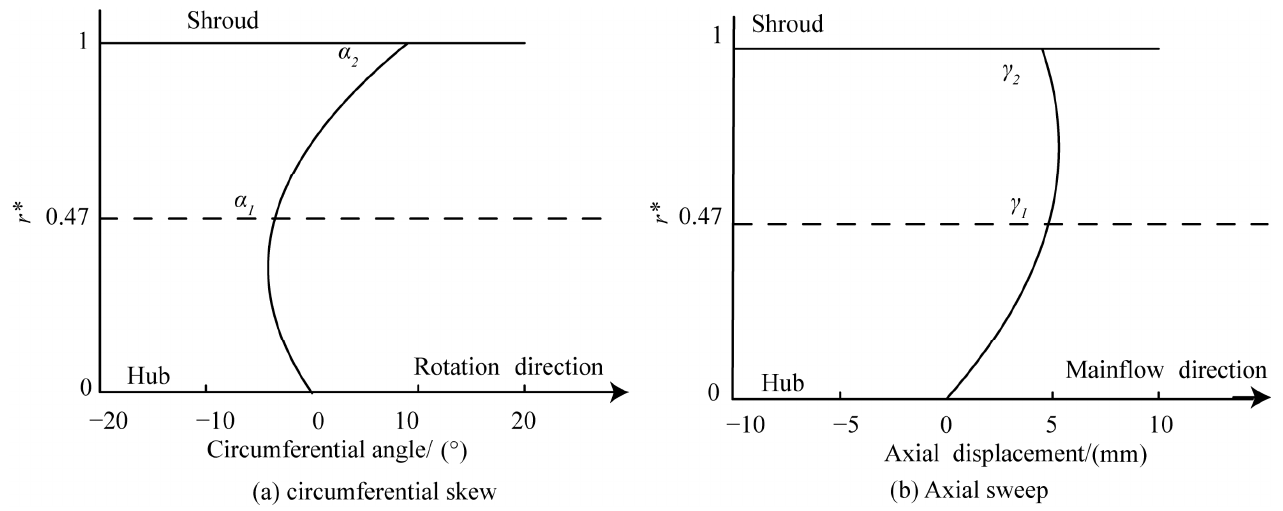
Figure 6. Schematic diagram of the blade stacking modes. Based on the above analysis, the impeller has a total of 12 design parameters, and the value range of each parameter is shown in Table 2. Among them, the variation range of the solidity, hydrofoil stagger angle, and hydrofoil camber is ±10% of the original values. Table 2. Range of design parameters.